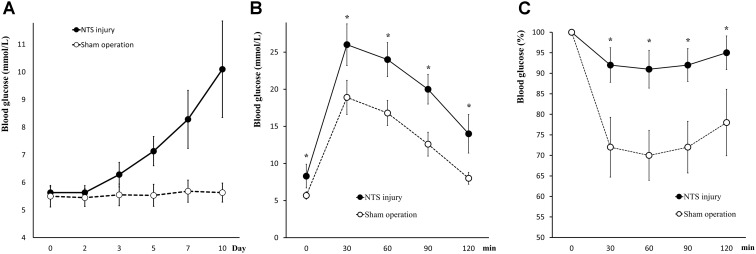
Changes in glucose metabolism in acNTS injured mice. (A) The trend of postoperative fasting blood glucose levels. Mechanical damage to acNTS can cause fasting blood glucose to increase gradually. (B) GTT. (C) ITT. Results showed that acNTS injured mice exhibit insulin-resistant hyperglycemia. Data in (B,C) were shown as means ± SEM, ∗p < 0.01.